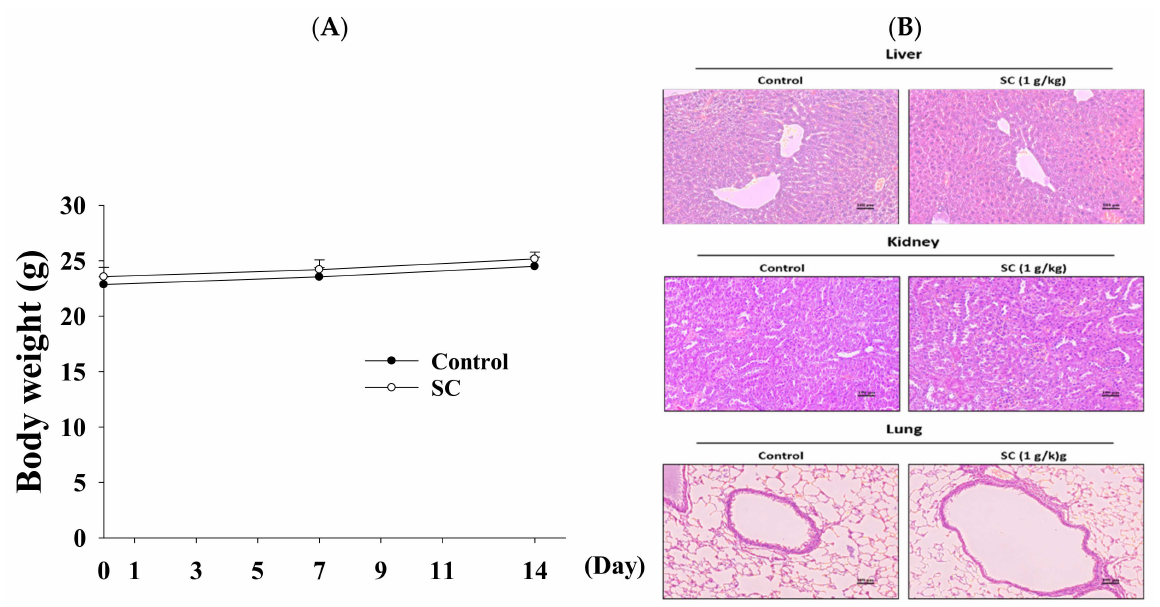
Figure 5. Effects of oral administration of SC in animal models. ( A ) The body weight of mice was calculated after pretreatment with 1.0 g/kg SC. H&E staining images were captured in the liver and kidney tissue (200 × ) ( B ). The representative histology of mouse liver, kidney, and lung sections after H&E staining is magnified and photographed. Data are the means ± SD ( n = 6).